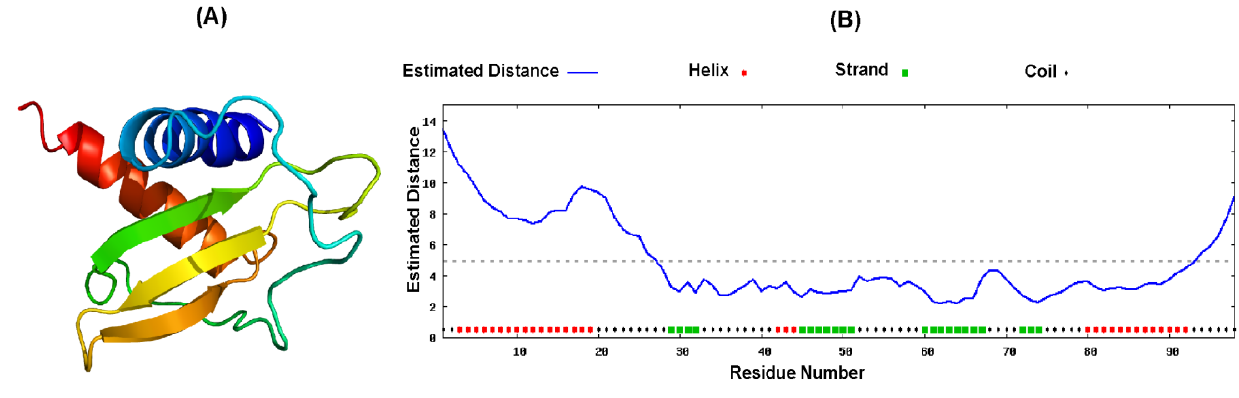
Figure 1. The structure modeling results of CXCL10. ( A ) I-TASSER model; ( B ) Estimated local